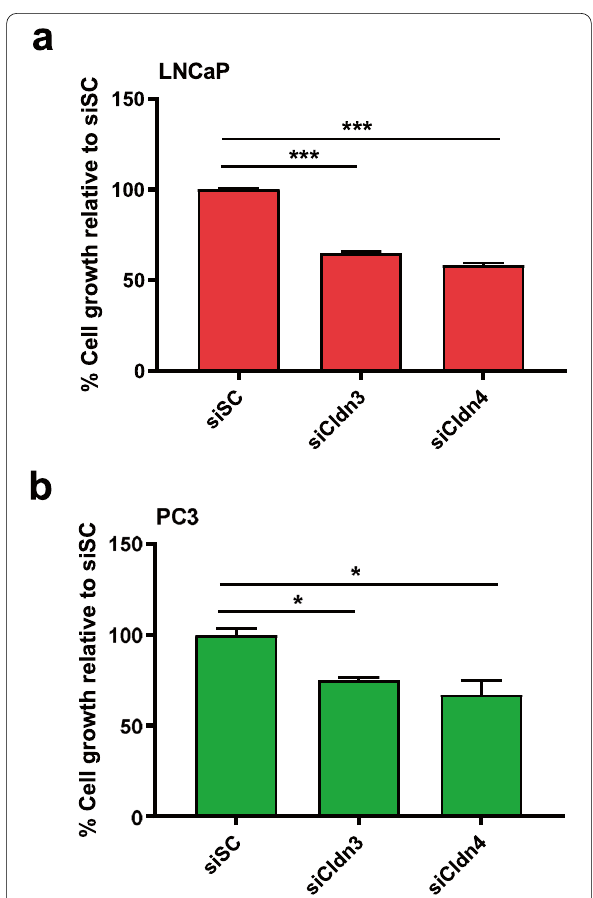
Fig. 3 Assessment of cell growth upon siCldn treatment. Cell growth of ( a ) LNCaP and ( b ) PC3 human prostate cancer cells following siCldn3 or siCldn4 treatment relative to growth following siSC. Data are shown as mean SD of 3 to 4 independent experiments. * ± represents p < 0.05 and *** represents p <